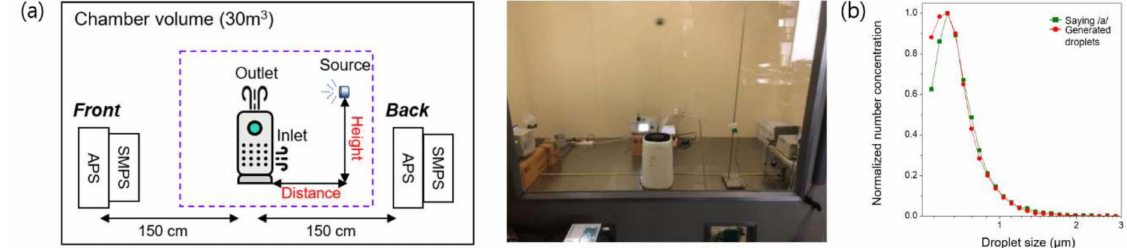
Figure 1. Experimental setup and the size distribution of the simulated respiratory droplet nuclei. ( a ) Schematic and photograph of the experimental setup; ( b ) comparison between the actual and simulated respiratory droplet